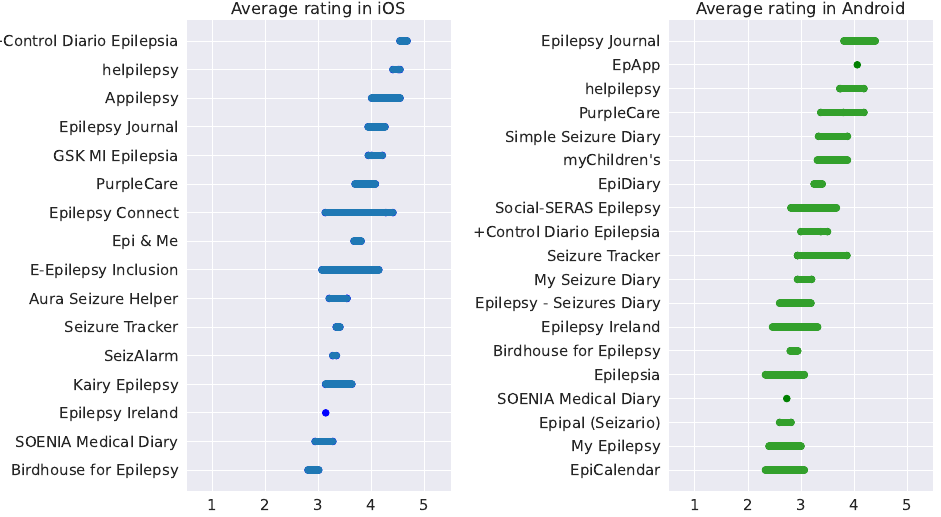
Figure 4. Overall rating of each app. The left side plot contains apps evaluated in the iOS system, whereas the right side corresponds to apps evaluated within the Android system. On the left, the scores vary between 2.9 and 4.5, while on the right, the scores range from 2.1 to 4.1.